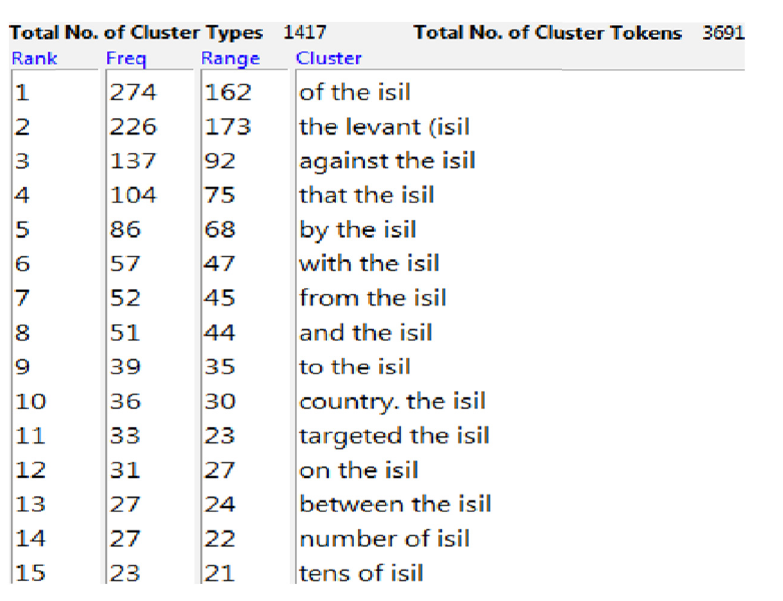
Figure 5: Three - word clusters of